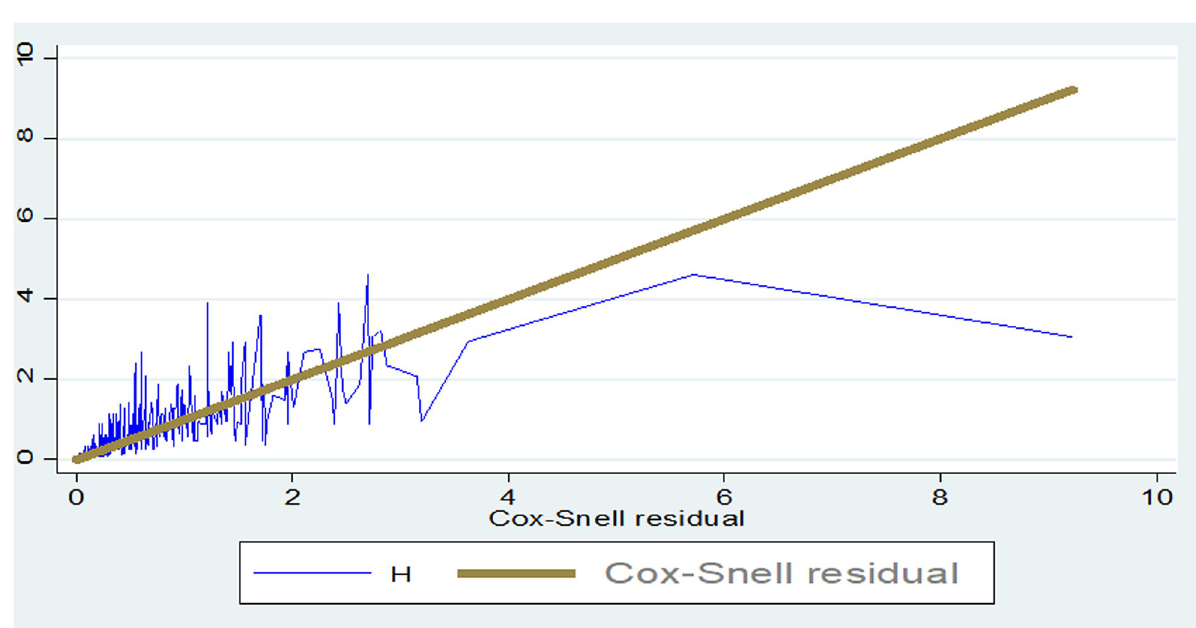
Fig 3. Goodness of fit test for univariate distribution of Weibull hazard